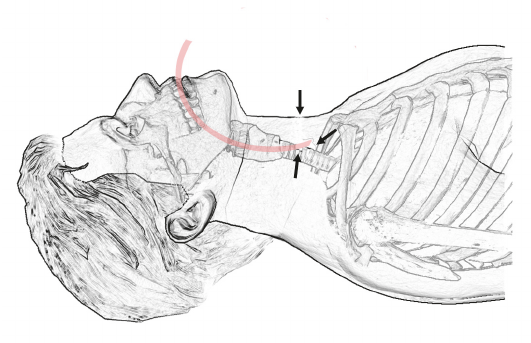
Figure 1: Visual presentation of the tubeand the via falsa anteriorto the trachea (arrows pointing to the tracheostomy and the via falsa).